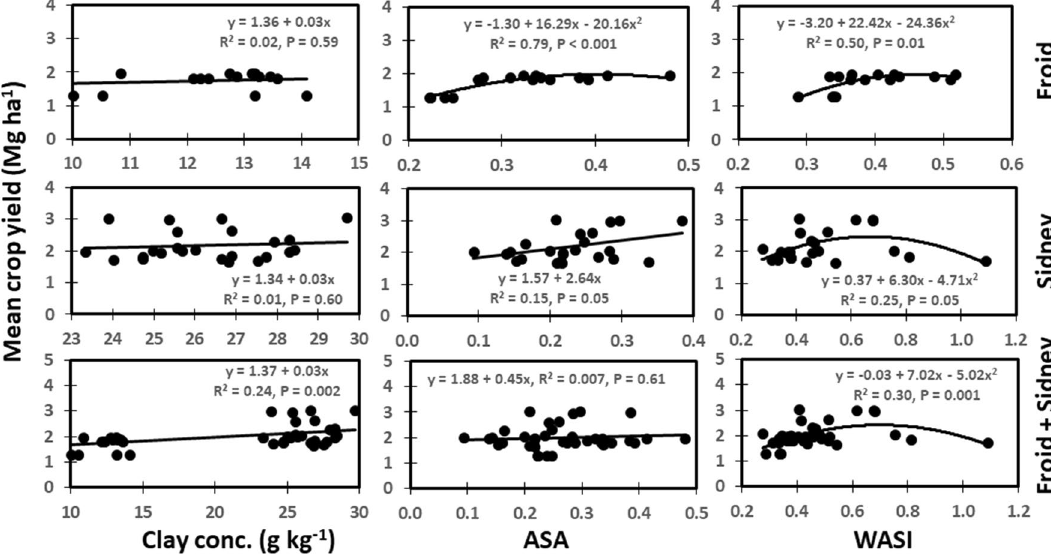
Figure 4. Relationships among clay concentration, average slake aggregate (ASA), wet aggregate stability index (WASI), and mean crop yield across years at Froid, Sidney, and the combined data from Froid and Sidney.